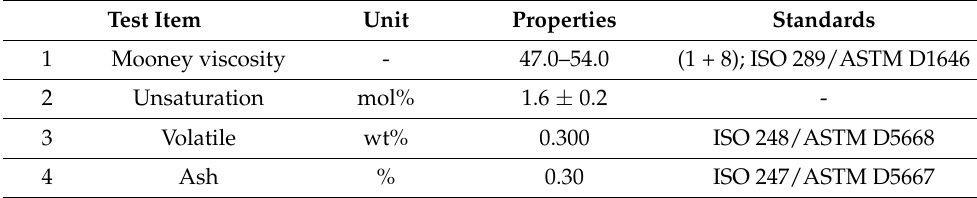
Table 3. Butyl rubber properties used in the